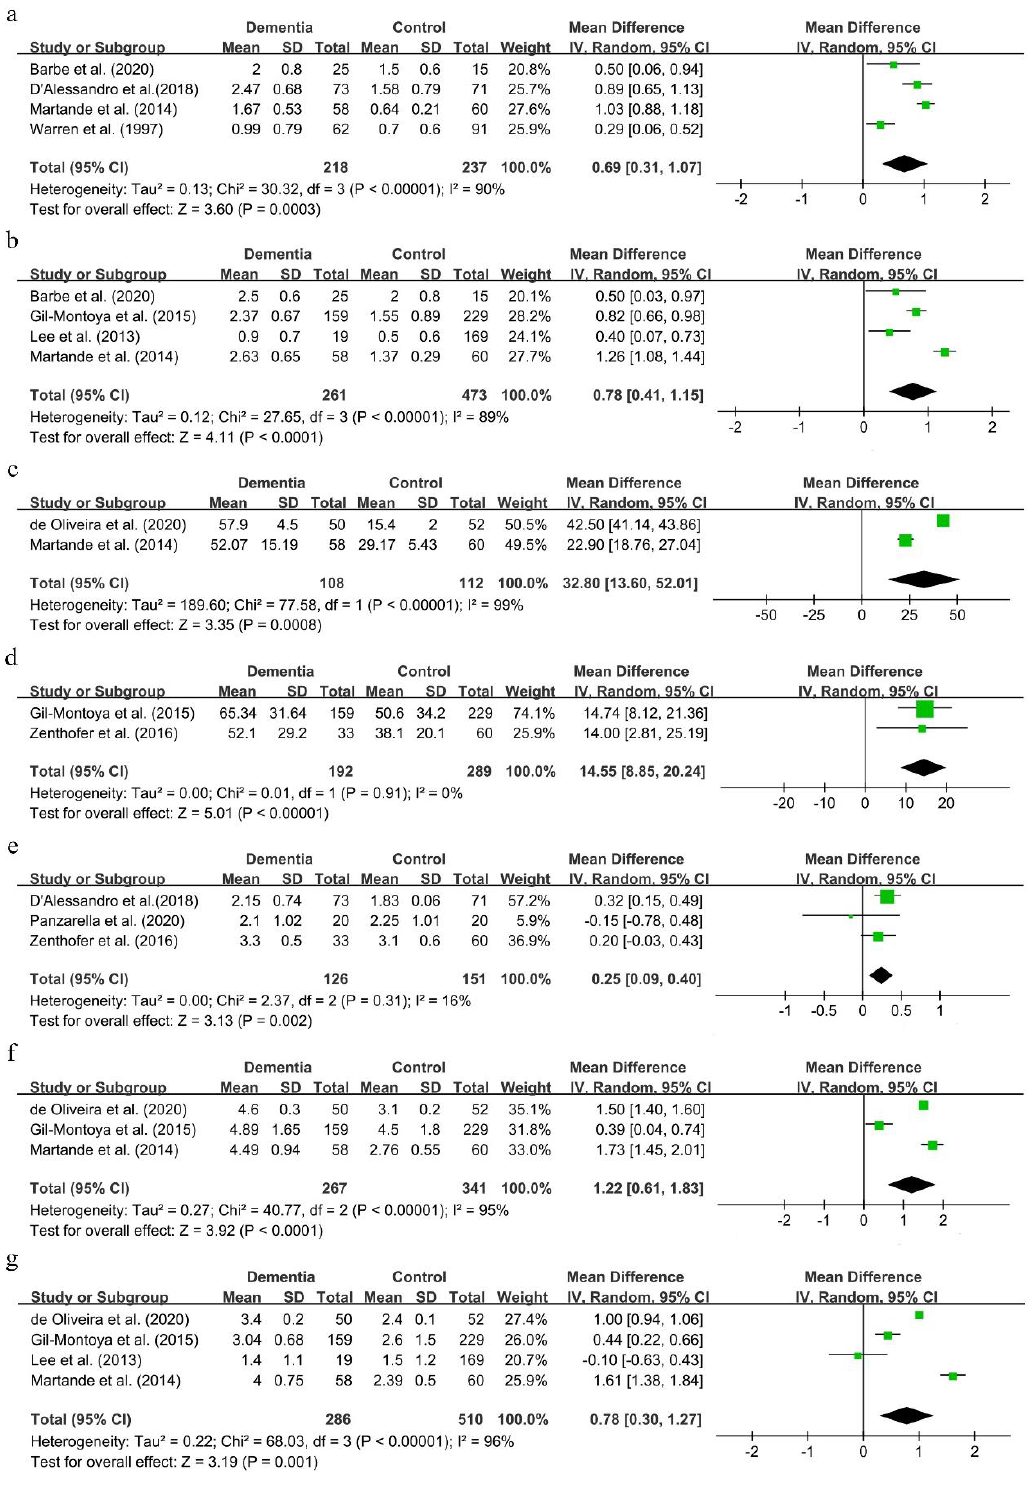
Figure 5. Forest plot of periodontal status in dementia patients ( a ). GI; ( b ). PI; ( c ). BOP; ( d ). GBI; ( e ). CPI; ( f ). CAL; ( g ). PPD.